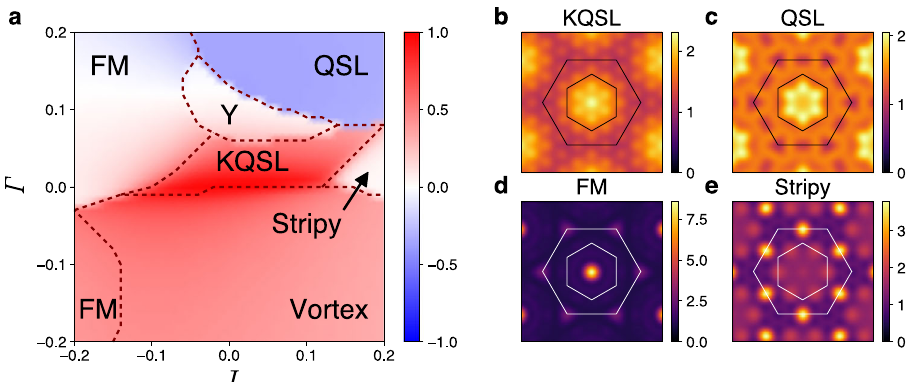
Fig. 6 Ferromagnetic KQSL and nearby magnetic states. a Phase diagram of H KJ ΓΓ 0 at K = − 1 and Γ 0 ¼ 0 : 05. The color encodes the fl ux operator expectation value h ^ W p i , and the dashed lines denote phase boundaries determined by the ground state energy second derivatives − ∂ 2 E gs / ∂ ξ 2 ( ξ = J , Γ ). b – e Color maps of the spin structure factor S ( q ) for the KQSL, QSL, ferromagnetic (FM), and stripy states. The inner and outer hexagons denote the fi rst and second Brillouin zones of the honeycomb lattice.